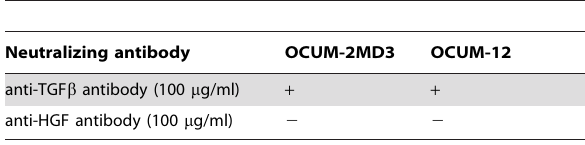
Table 2. Effects of neutralizing antibodies on cancer cell morphology under hypoxia.